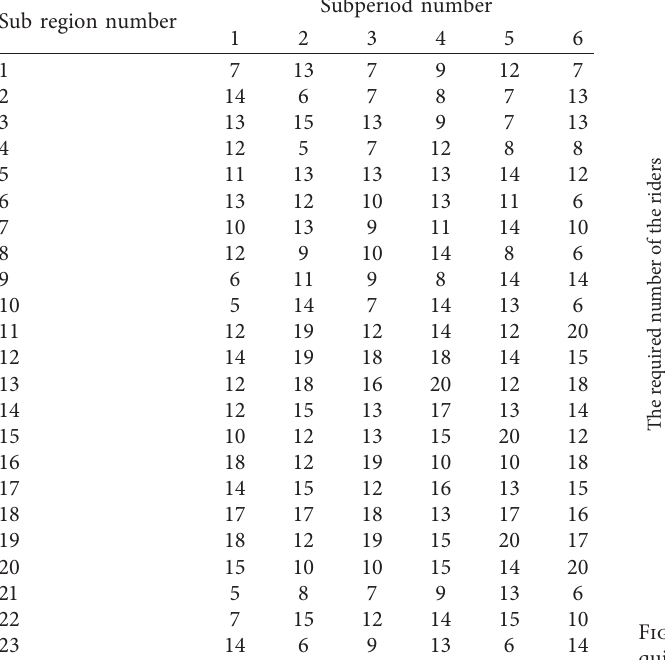
Figure 9: Relationship between the number of riders and the number of orders per capita under different time windows.